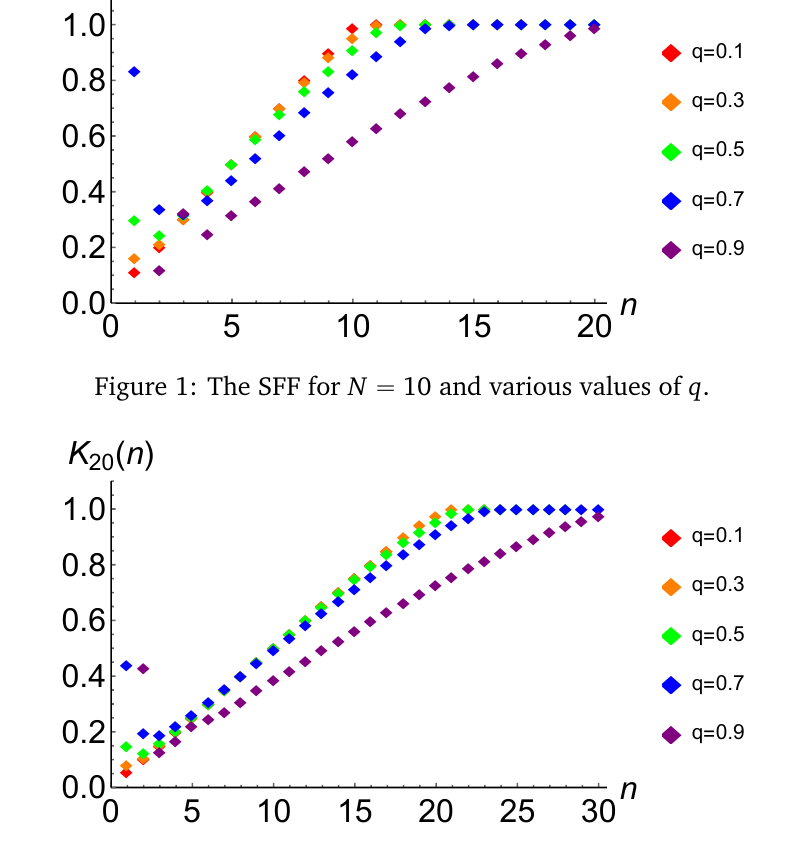
Figure 2: The SFF for N “ 20 and various values of q